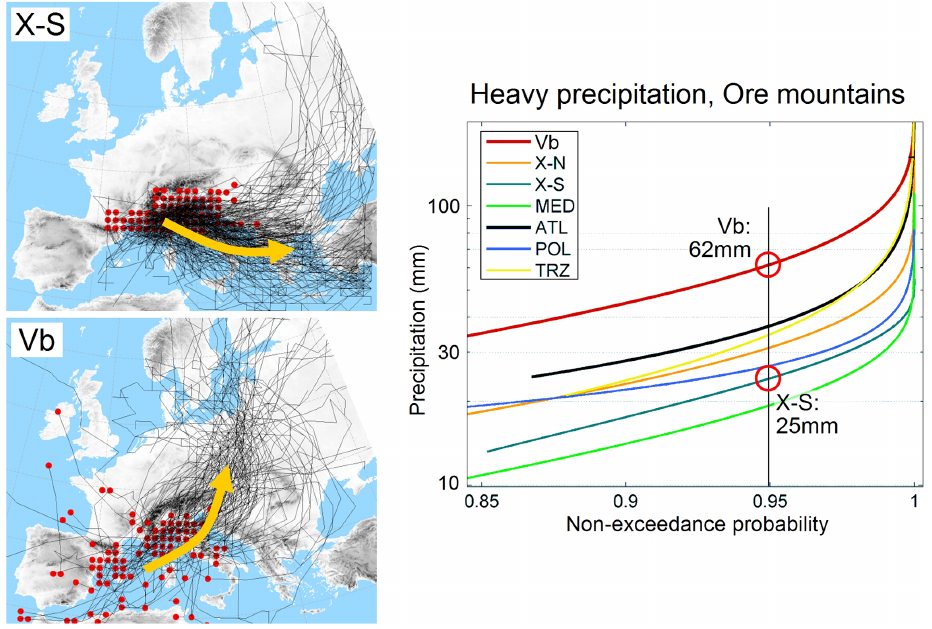
Figure 9. Storm tracks of cyclone types and associated heavy precipitation in the Ore mountains, for 2500 cyclone events. From information in Hofstätter et al. (2018).